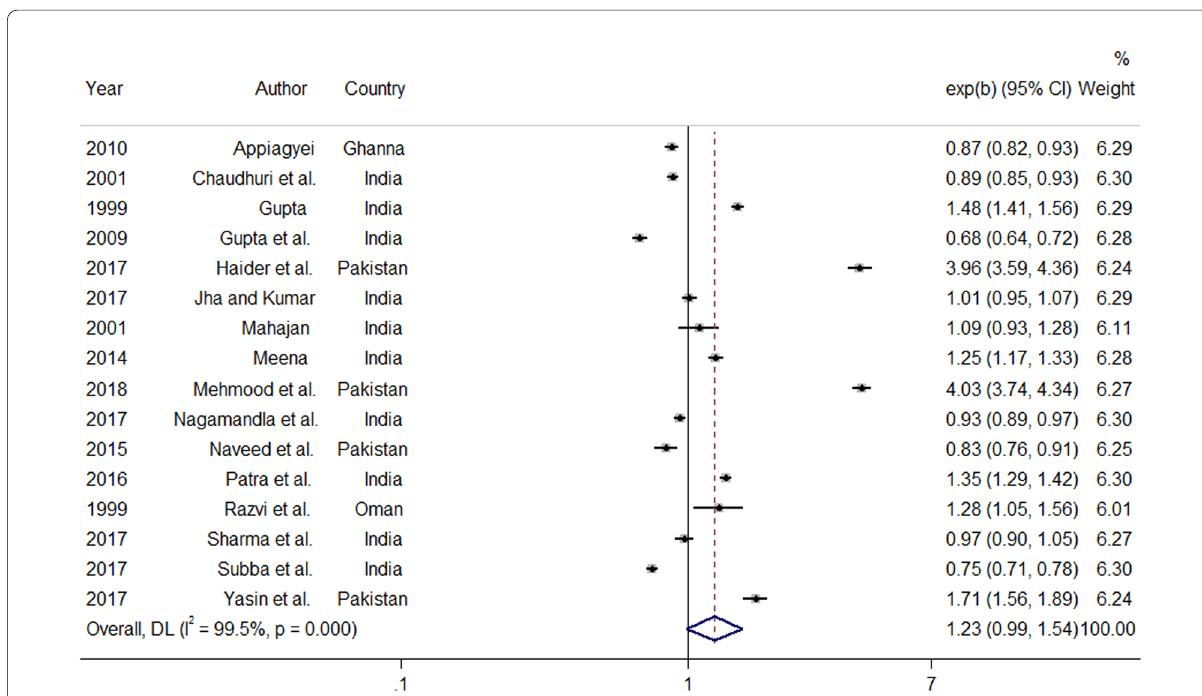
Fig. 3 Forest plot represented the Zr statistics. The diamond denoted the point estimate and confidence intervals when all the individual studies are combined and averaged together. If the horizontal tips of the diamond crossed the vertical line, the presence of heterogeneity would be rejected. However, the overall I Squared ( I 2 ) was equal to 99.5% (p‑value 0.000), in which there was a high degree of heterogeneity between studies. The = fixed‑effects assumption of similar true effect in each study was strongly rejected. Weights were from random‑effects